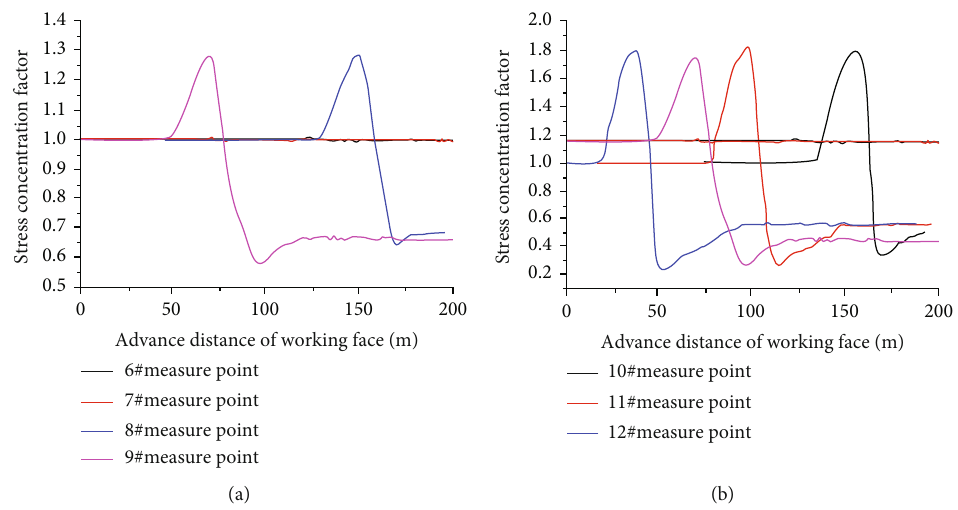
Figure 11: Stress concentration coe ffi cient curves of each mining point in the W coal seam.